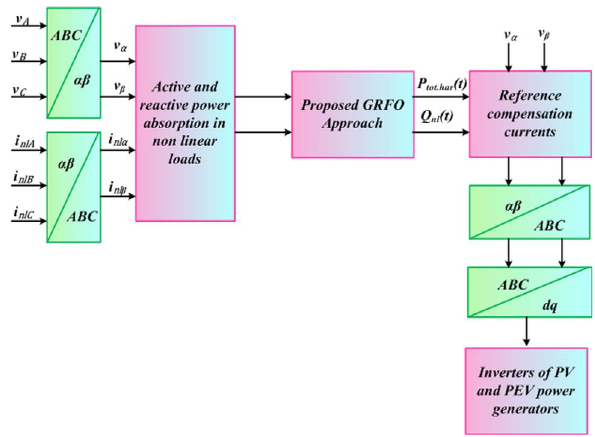
Figure 2. Control structure of the proposed